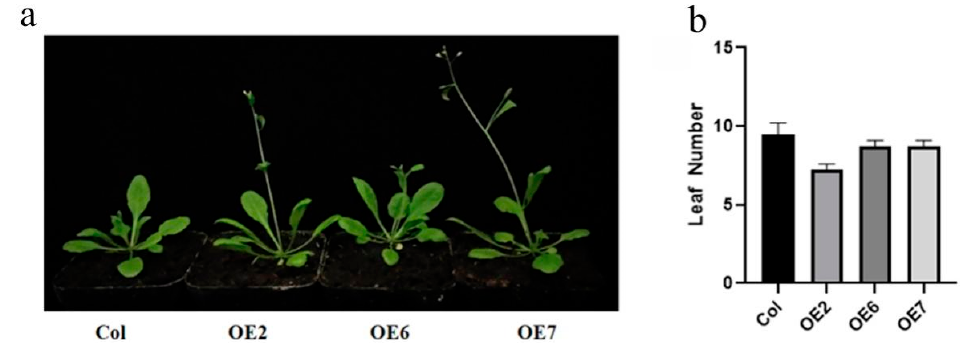
Figure 8. Regulation of flowering time and leaf number by ZmPRMT1 in transgenic Arabidopsis lines. ( a ) The early-flowering phenotype of transgenic Arabidopsis lines was observed. The left figure shows the phenotype of the WT and transgenic Arabidopsis lines 2, 6 and 7. Seedlings of these 4 different Arabidopsis lines were grown in the temperature incubator at 22 ◦ C under long-day conditions (16 h light and 8 h dark) and 60% relative humidity. After 27 days, 4 different Arabidopsis lines flowering successively. ( b ) Total leaf number of transgenic Arabidopsis lines was calculated. The right figure shows leaf number of the corresponding plants left. Total leaf number of WT, transgenic Arabidopsis 2, 6 and 7 was calculated under same